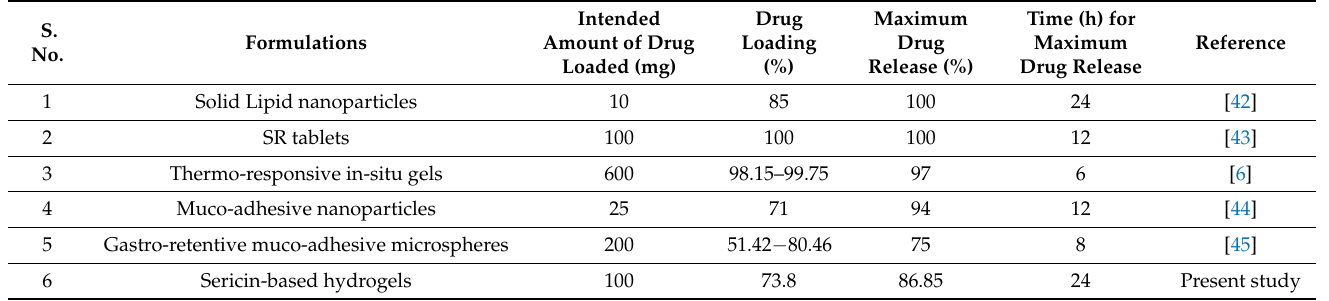
Table 5. Comparison of sericin based hydrogels with other delivery techniques for acyclovir. S.